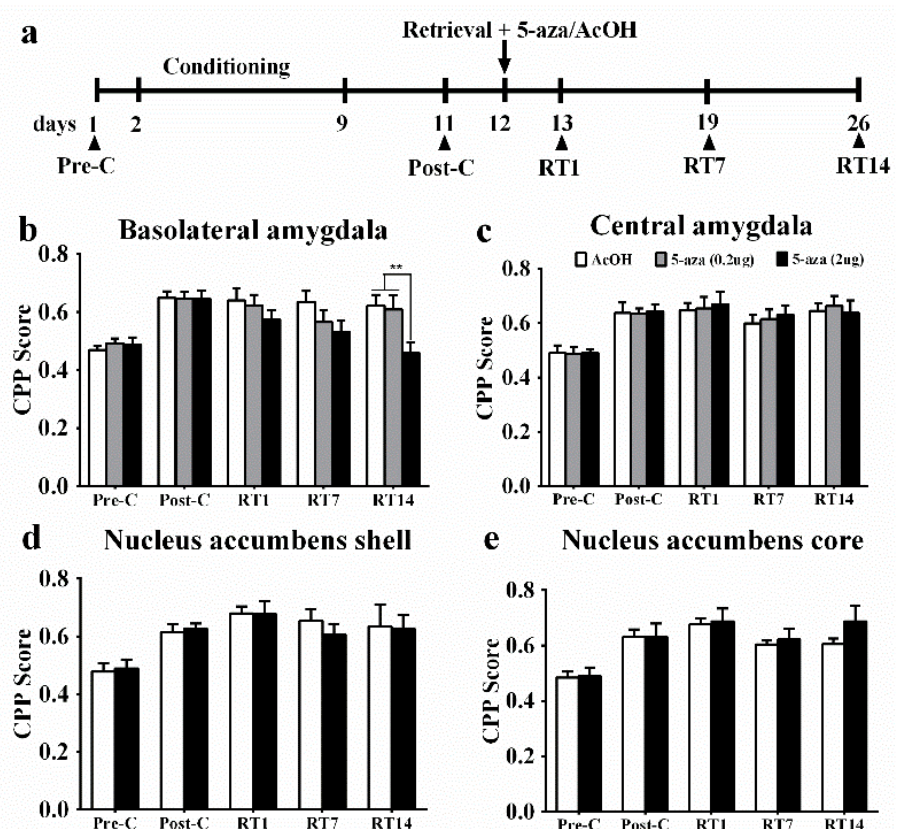
Figure 1. Effect of injection of 5-aza into the basolateral amygdala (BLA) and nucleus accumbens (NAc) on the reconsolidation of morphine reward memory. ( a ) Timeline of the experiment. ( b ) Injection of 5-aza (2 µg) into the BLA immediately after memory retrieval impaired memory reconsolidation of mCPP ( n = 8–10). ( c ) Injection of 5-aza (0.2 µg or 2 µg) into the central amygdala (CeA) did not affect reconsolidation ( n = 9–10). ( d ) Injection of 5-aza (2 µg) into the NAc shell did not affect reconsolidation ( n = 7). ( e ) Injection of 5-aza (2 µg) into the NAc core did not affect reconsolidation ( n = 7–11). Data are the mean ± SEM of preference scores during the CPP tests. ** p < 0.01, compared to acetic acid (AcOH) injection at the same time-point. The schematic representation of the injection sites: see Figure S1.